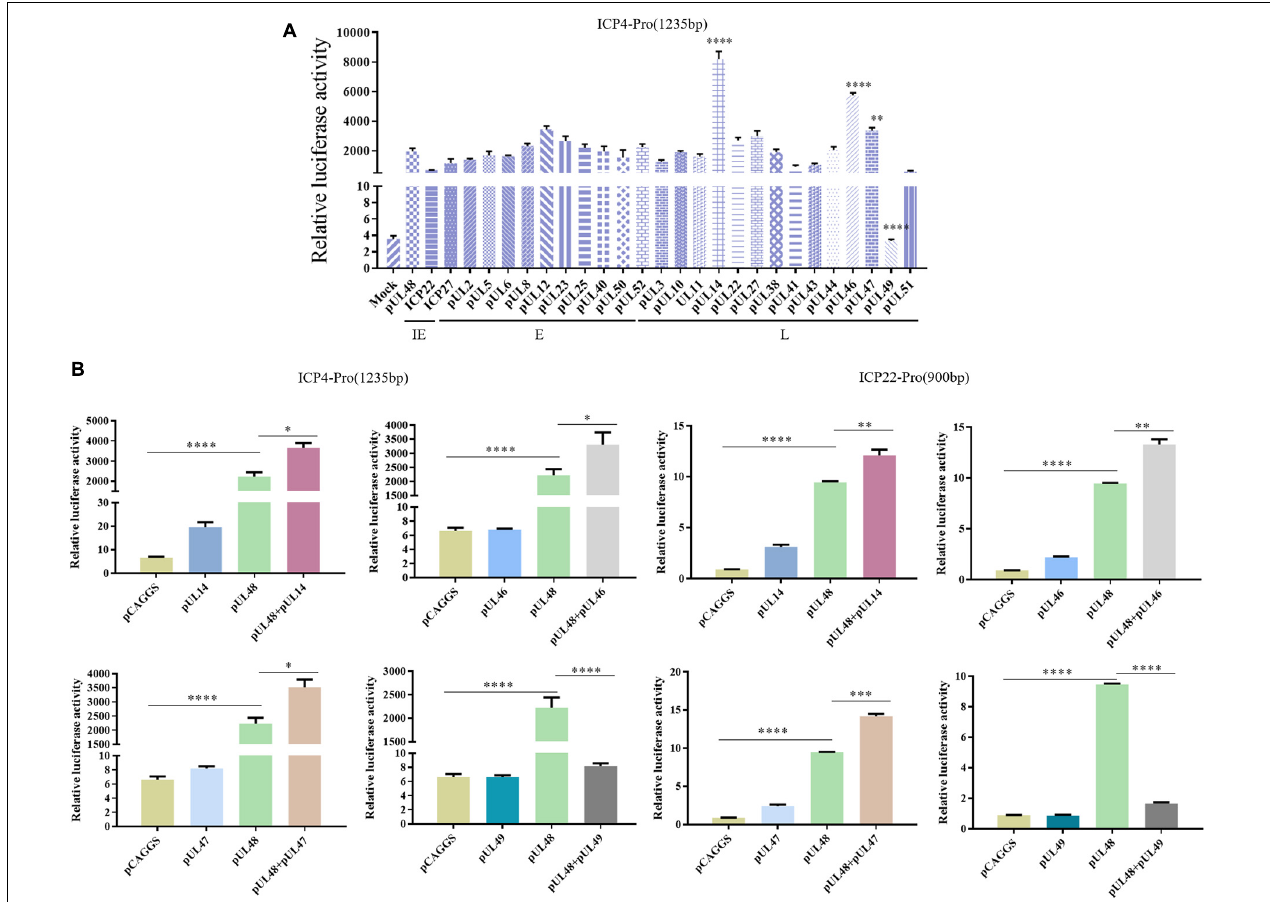
FIGURE 7 | Screening of viral proteins affecting the transcriptional activation of pUL48. (A) Various viral proteins affected the activation of pUL48 on ICP4-Pro (1,235 bp). The Mock: pCAGGS + ICP4-Pro (1,235 bp); Control: pUL48 + ICP4-Pro (1,235 bp); ICP22: ICP22 + pUL48 + ICP4-Pro (1,235 bp). The other groups were set up in the same way as ICP22. Will pGL4-ICP4-Pro(1235 bp)-Luc, reference plasmids pRL-TK, and pCAGGS-pUL48-HA were cotransfected with 26 eukaryotic expression plasmids of DPV protein, including pCAGGS-UL2-Flag and pCAGGS-UL47-Flag, respectively (the control group was transfected with the same amount of pCAGGS without loading), and the samples were collected at 24 h. The relative fluorescence intensity of the transfected virus protein group and the control group was detected and compared with screen out, the viral target protein that affected the transcriptional activation function of pUL48. (B) The activation of ICP4 and ICP22 promoters by pUL48 was regulated by pUL14/pUL46/pUL47/pUL49. It was verified that the target protein did not affect the IE gene promoter but regulated the transcriptional activation function of pUL48. Student’s t -test was used to analyze the differences of the two groups. ∗ p < 0.05, ∗∗ p < 0.01, ∗∗∗ p < 0.001, ∗∗∗∗ p <